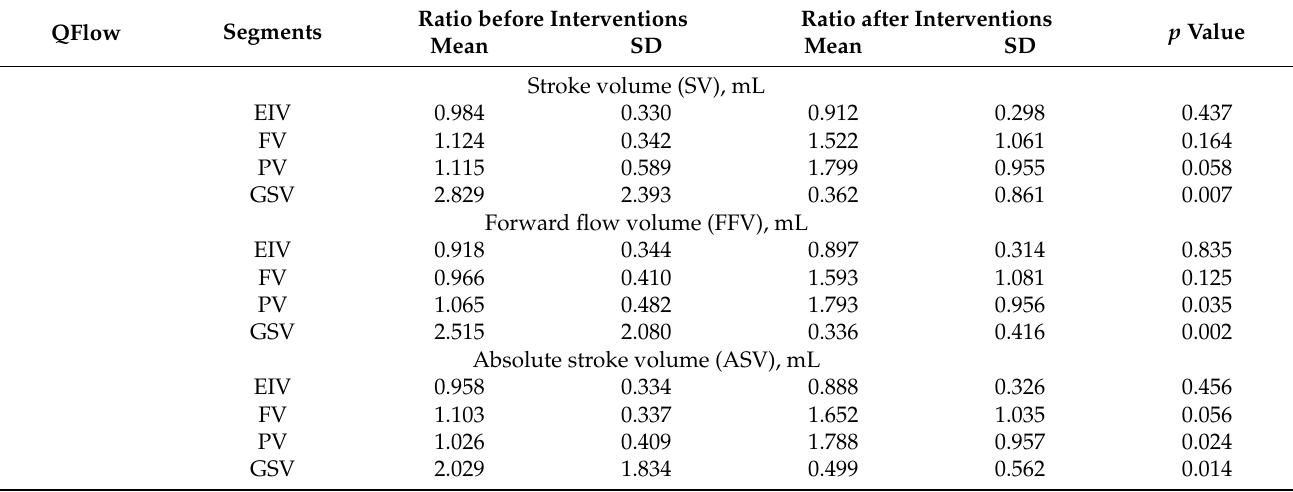
Table 4. Parameter ratio of target to non-treated limb: before and after